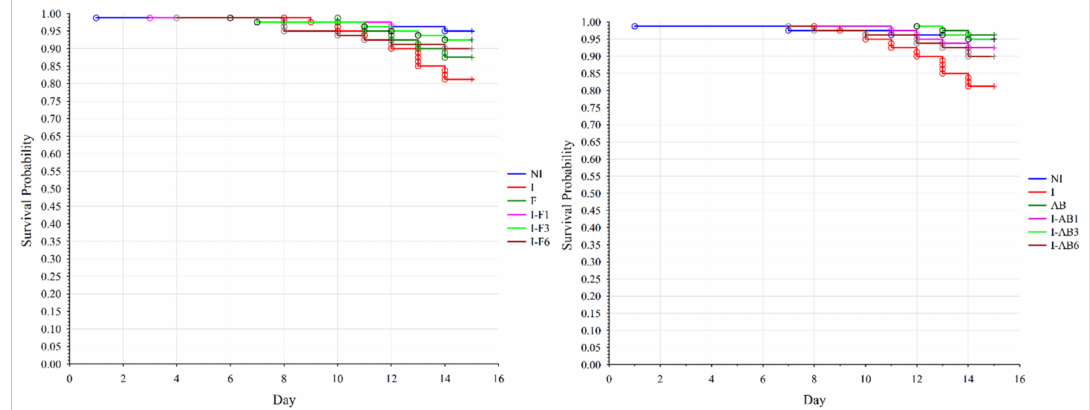
Figure 2. Effects of treatment with fumagillin and A. blazei extract on the survival rate of N. ceranae infected bees. Survival rate was based on the daily accumulated mortality. The comparison was made between the non-infected control (NI), N. ceranae infected control (I) and groups infected and treated with fumagillin from day 1 (I-F1), day 3 (I-F3) and day 6 (I-F6) or